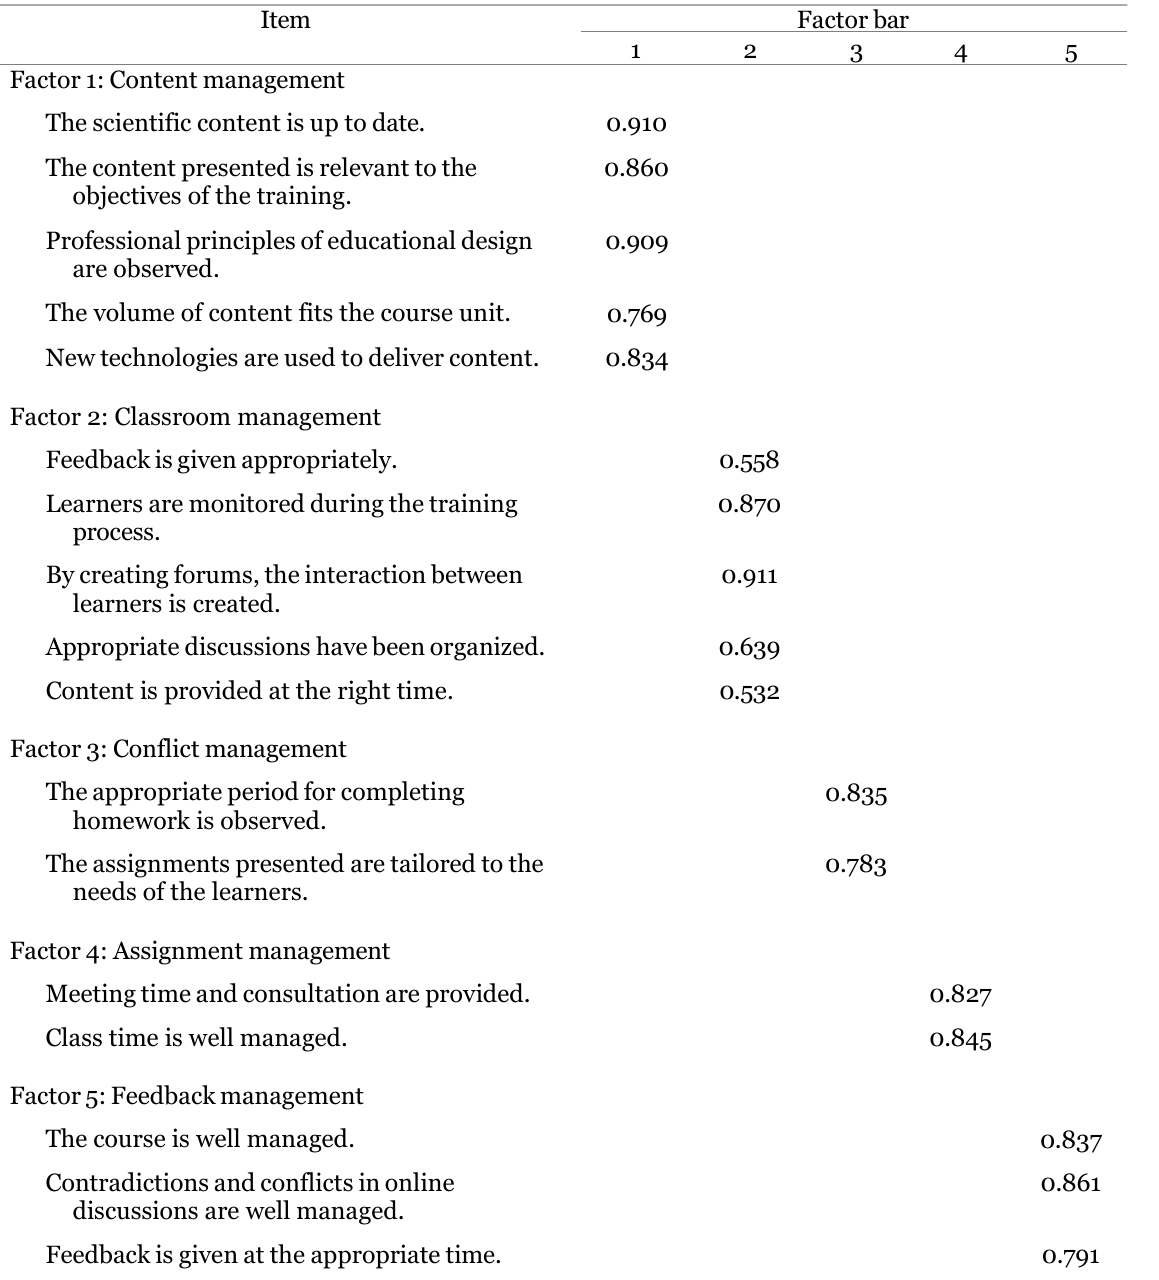
Table 4 Rotated Factor Matrix by Principal Component Analysis and Varimax Rotation After Exploratory Factor